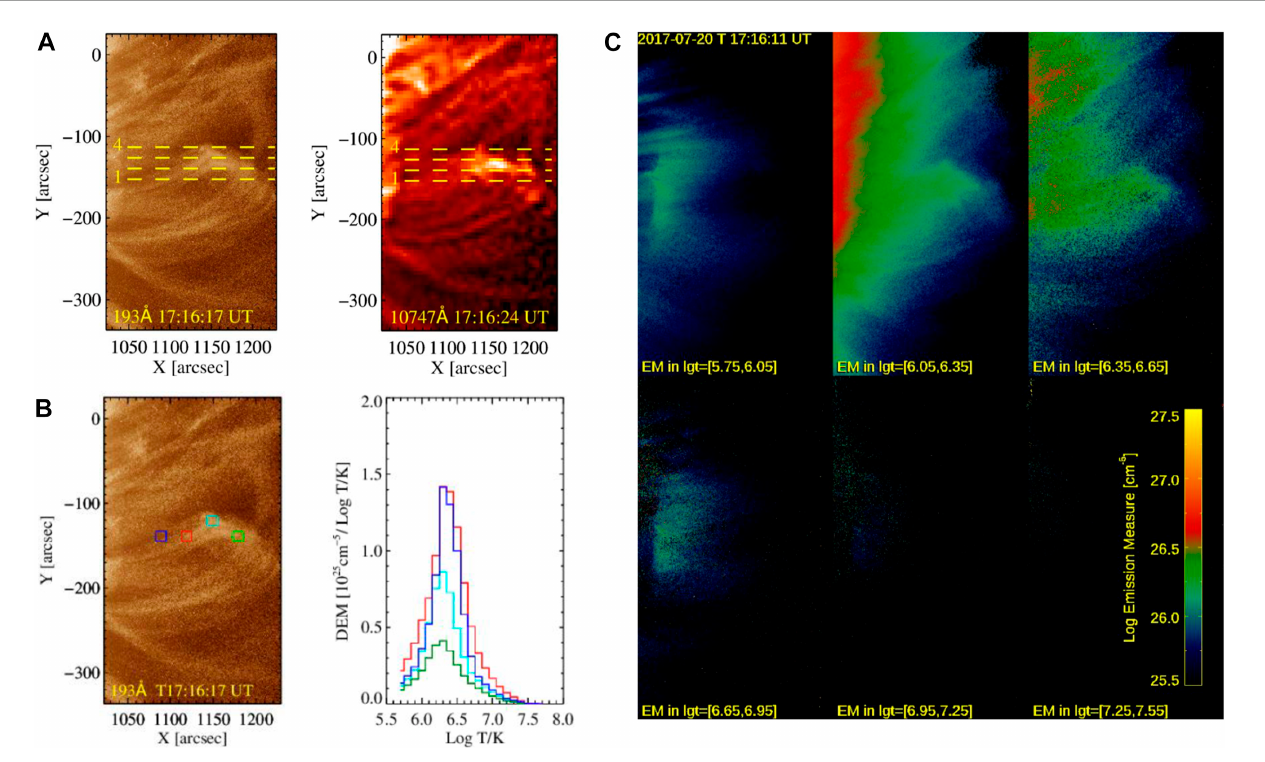
FIGURE 2 (A) The left panel shows the AIA ROI (shown by yellow box in Figure 1C ), and right panel shows the CoMP ROI (shown by yellow box in Figure 1B ). The yellow dashed lines in both panels show the locations of four co-spatial slits chosen in the two ROIs. (B) The left panel shows AIA 193 Å ROI image at 2017–07–20 T 17:16:17 UT. The colored boxes show the selected sub-regions used to reconstruct the DEM curves. The DEM curves for these box regions are shown in the right panel. The DEM in all regions peaked at around log T/K ∼ 6.3. (C) EM maps of the AIA ROI at 2017–07–20 T 17:16:11 UT. The color coding indicates the total EM contained within a log temperature range indicated in the bottom left corner of each panel. (An animation is available in the Electronic Supplementary